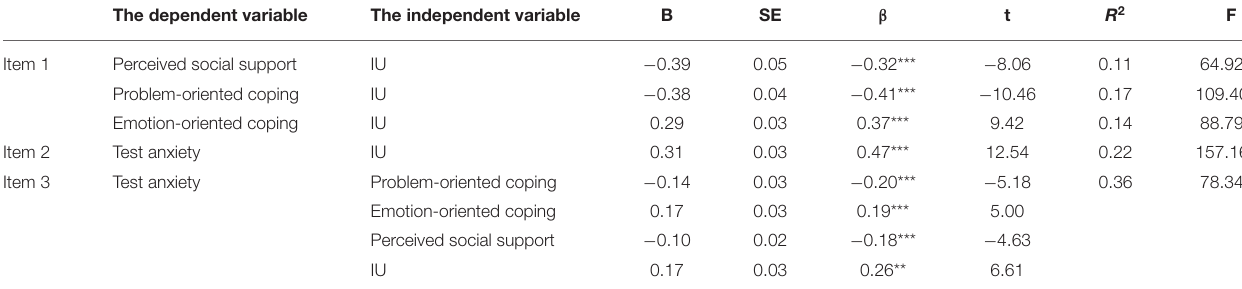
TABLE 3 | Mediating regression